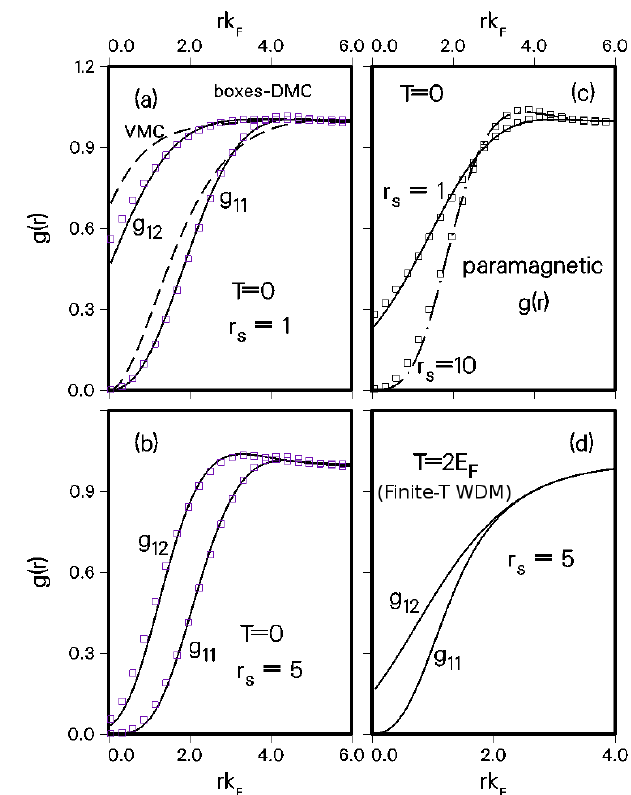
Figure 3. ( a ) Here, the CHNC g(r) are compared with VMC and DMC simulation results: the interacting PDFs g 11 ( r ) and g 12 ( r ) at r s = 1 are shown. Solid lines: CHNC, boxes: DMC, dashed line: VMC [79]; Panel ( b ) r s = 5, DMC [79] and HNC; In ( c ), the paramagnetic g ( r ) at r s = 1 and r s = 10, T = 0 are compared with DMC; ( d ) Finite temperature PDFs (CHNC) for T / E F = 2, r s = 5 would correspond to a WDM at (cid:39) 3.6 eV ( ∼ 42,000